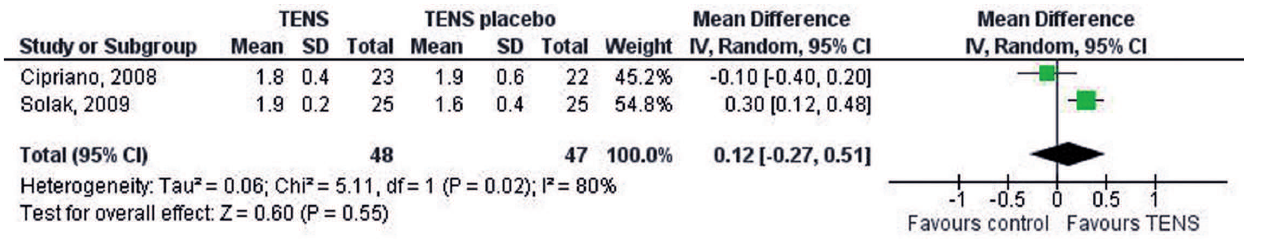
foi utilizado no período pós-operatório ser diferente